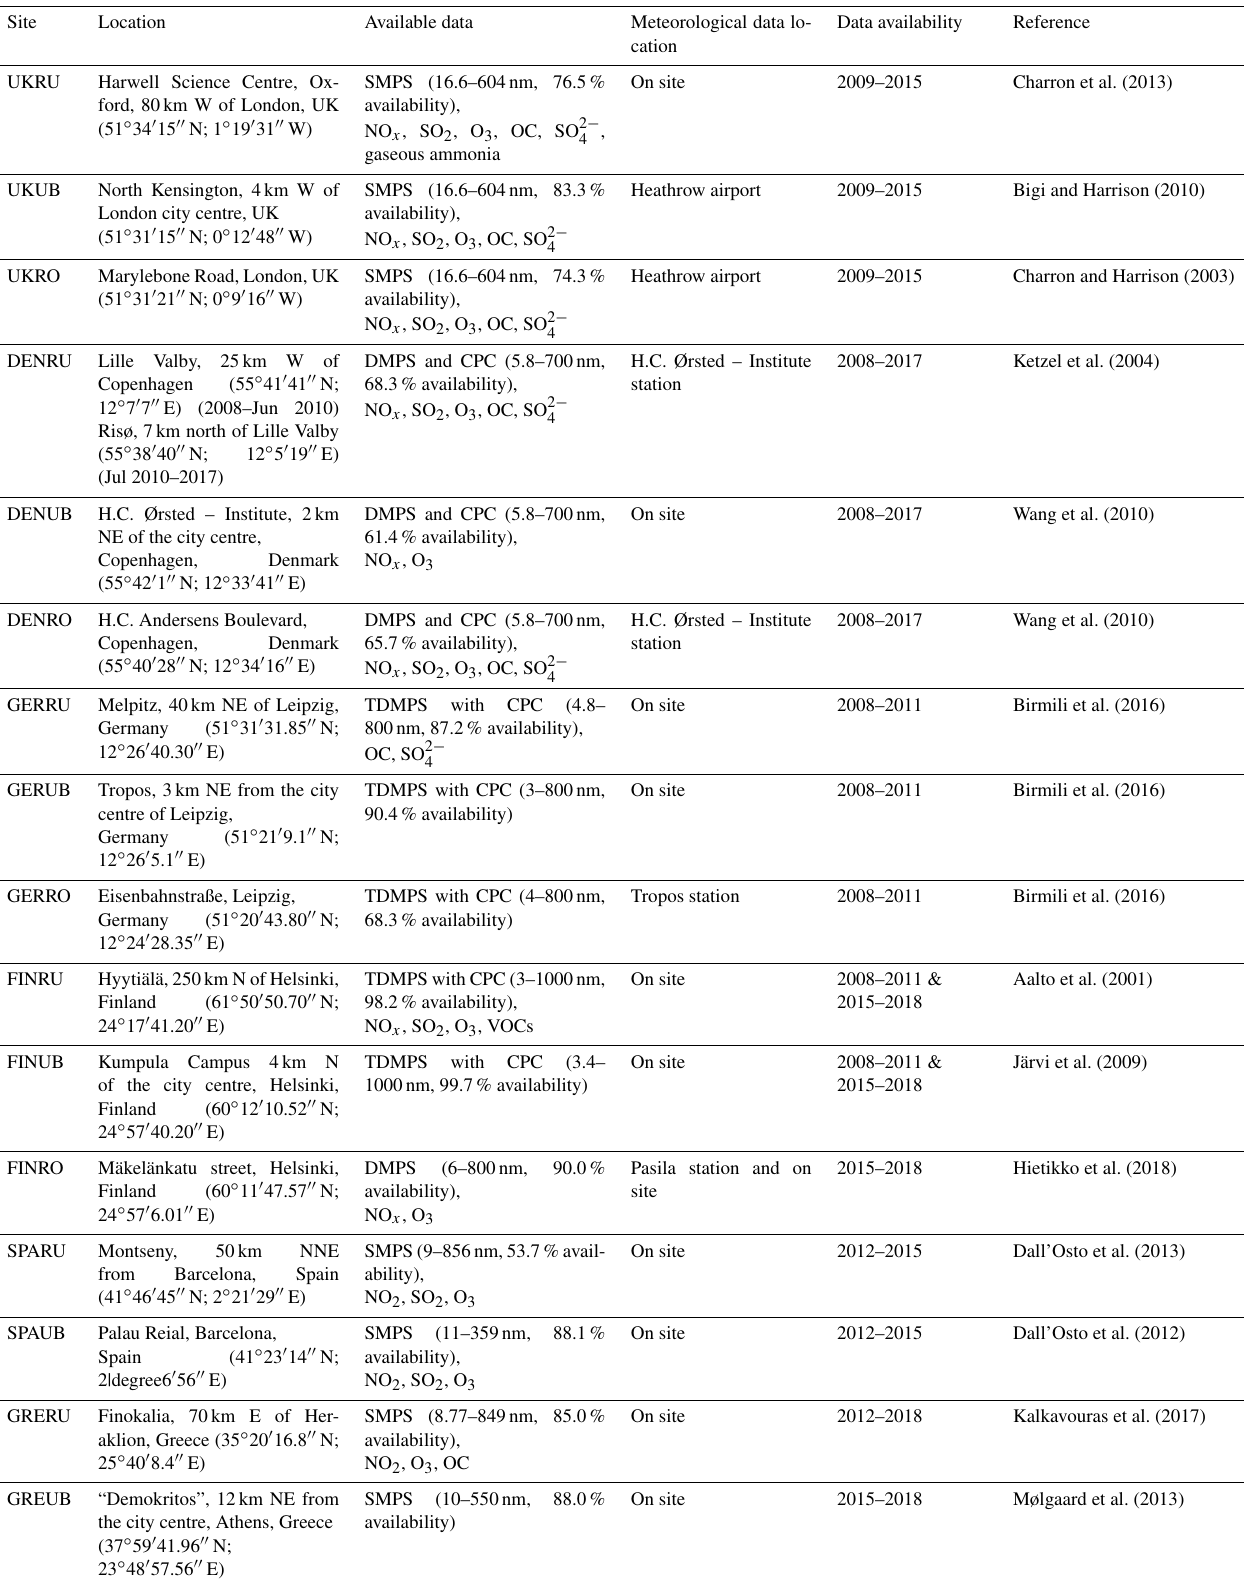
Table 1. Location and data availability of the sites.